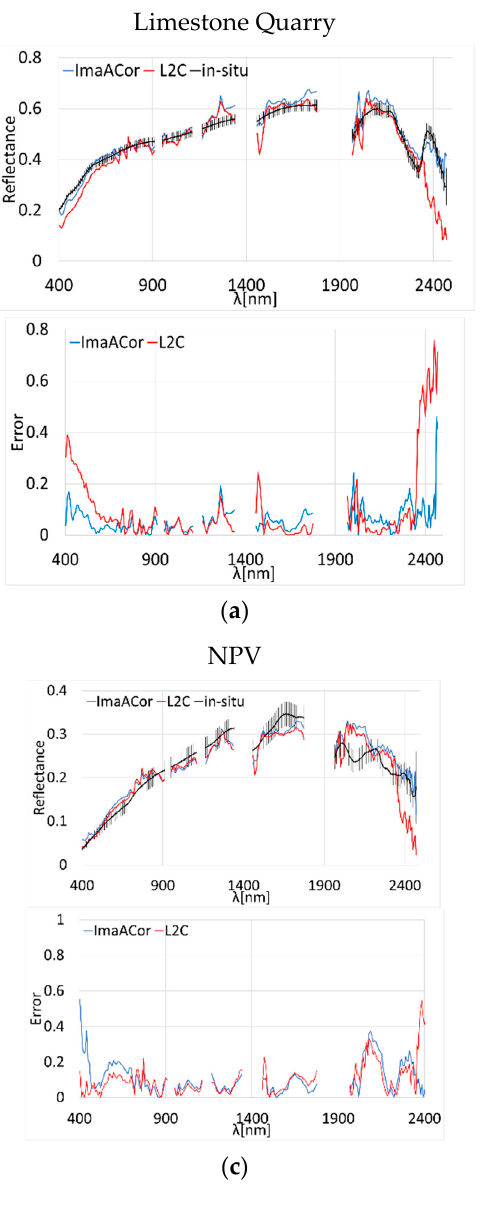
Figure 10. Comparison between L2C, ImaACor, and in situ reflectance spectra corresponding to: ( a ) the limestone quarry, ( b ) the airfield strip, ( c ) the NPV, and ( d ) the paved square targets. Vertical bars show the standard deviation related to the in-situ measurements. For each quadrant, the lower graph shows the relative spectral error between the L2C and the reference spectra and between the ImaACor and the reference spectra. Table 6. RRMSE (%) between the L2C reflectance and the reference in situ spectra and between the ImaACor reflectance and the reference in situ spectra corresponding to the limestone quarry, the airfield, the NPV, and the paved square